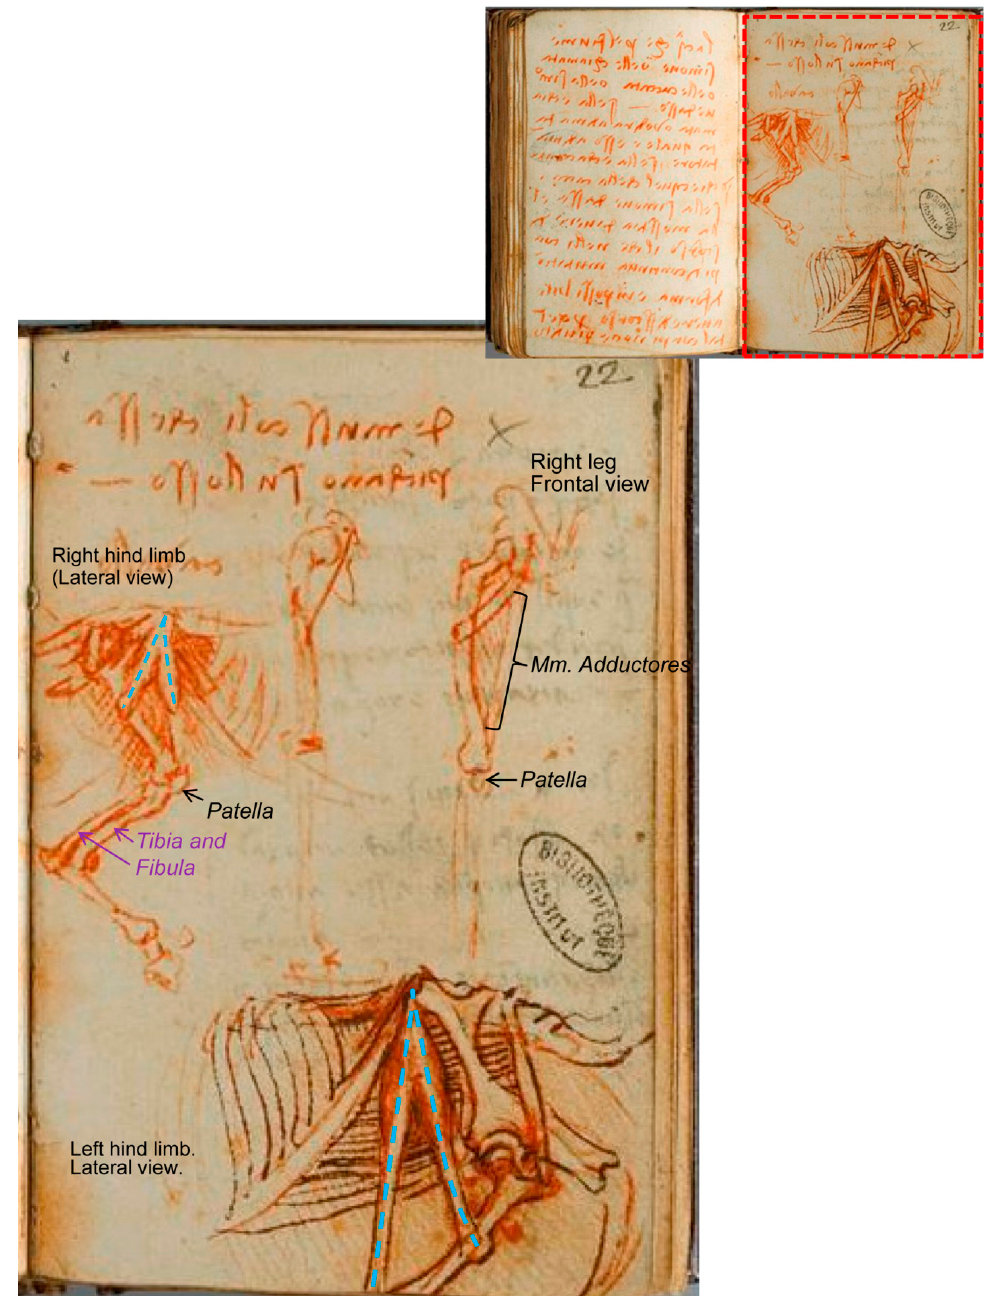
Figure 8. Series of the comparative anatomy of a man’s leg and horse’s pelvic limb—Number 2. ( A ) Two pages. ( B ) Inset: Higher magnification of Folio 102(22) recto: ‘Anatomie, cheval’. Modified from Ms 2181-folio 102(22)-manuscrit K (Bibliothèque de l’Institut de France [24]) (1503–1508). This image presentation is authorized in limited time period by R é union des Mus é es Nationaux-Grand Palais (R.M.N.-Grand Palais), and the Biblioth è que de L’Institut de France. Photo © RMN-Grand